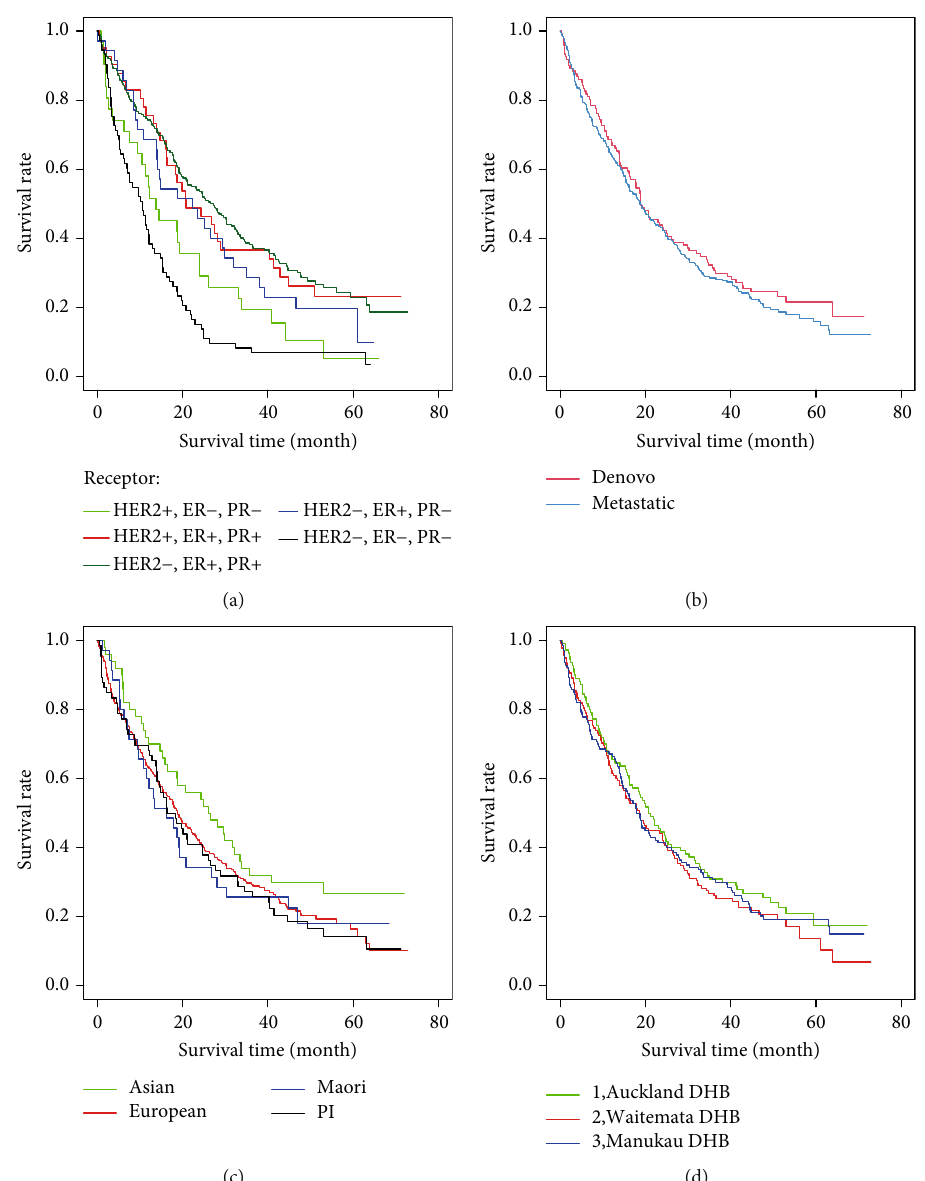
Figure 1: Survival curves based on (a) receptor subtypes, (b) De novo versus relapsed metastatic, (c) ethnicity, and (d) domiciliary district health